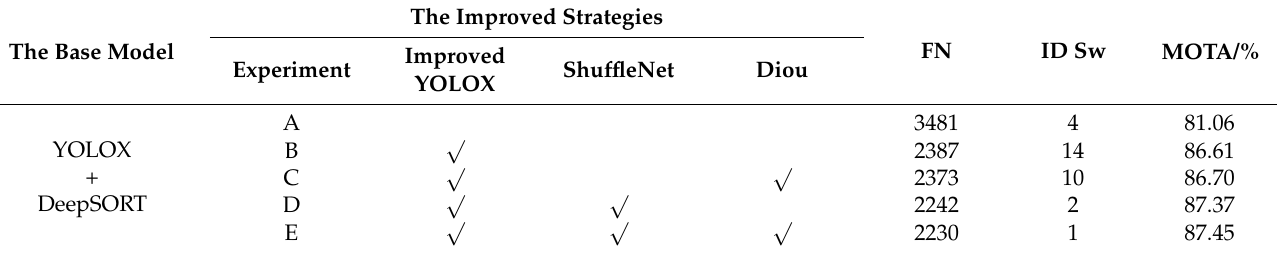
Table 5. The results of the improved